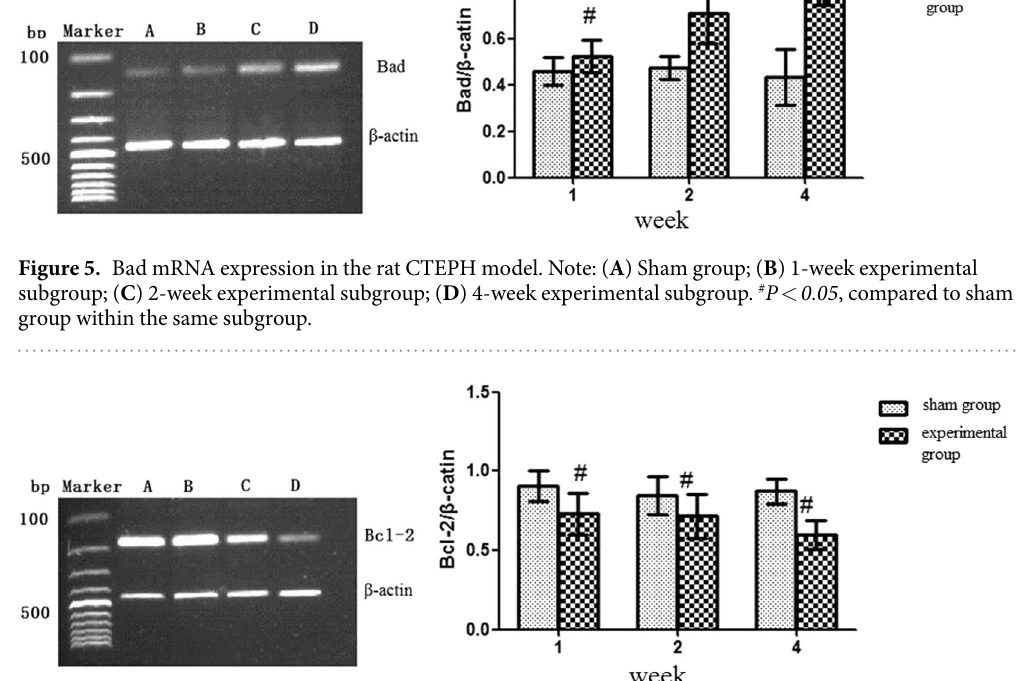
Figure 6. Bcl-2 mRNA expression in the rat CTEPH model. Note: ( A ) Sham group; ( B ) 1-week experimental subgroup; ( C ) 2-week experimental subgroup; ( D ) 4-week experimental subgroup. # P < 0.05 , compared to sham group within the same subgroup.